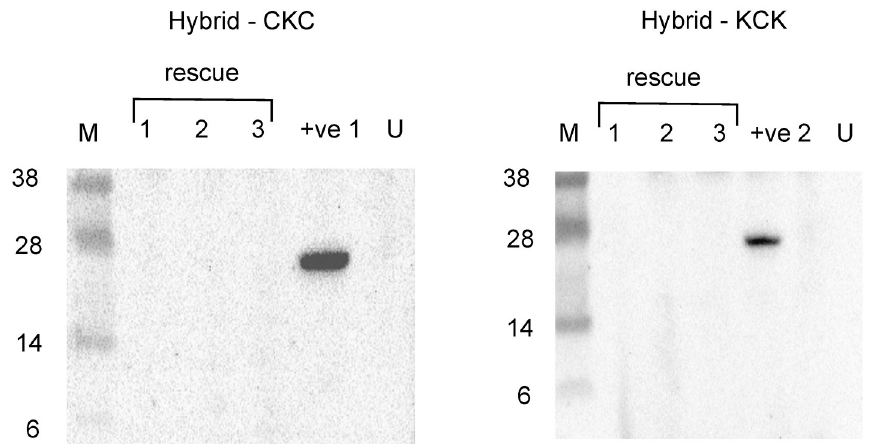
Fig 8. Attempted rescues of CVV and KRIV M segment reassortants. Western blot analysis showing the lack of N protein produced in 3 independent rescues for the hybrid viruses CKC and KCK (with segment order S-M-L). Supernatant from rescue experiment was passaged (1 ml of rescue supernatant added to BHK-21 cells for 5–7 days) and cell lysates used for western blotting using an anti-CVV N antibody for the hybrid CKC and an anti-KRIV N antibody for KCK. +ve 1, rCVV-infected cell lysate; +ve 2, rKRIV-infected cell lysate; U, uninfected cells.